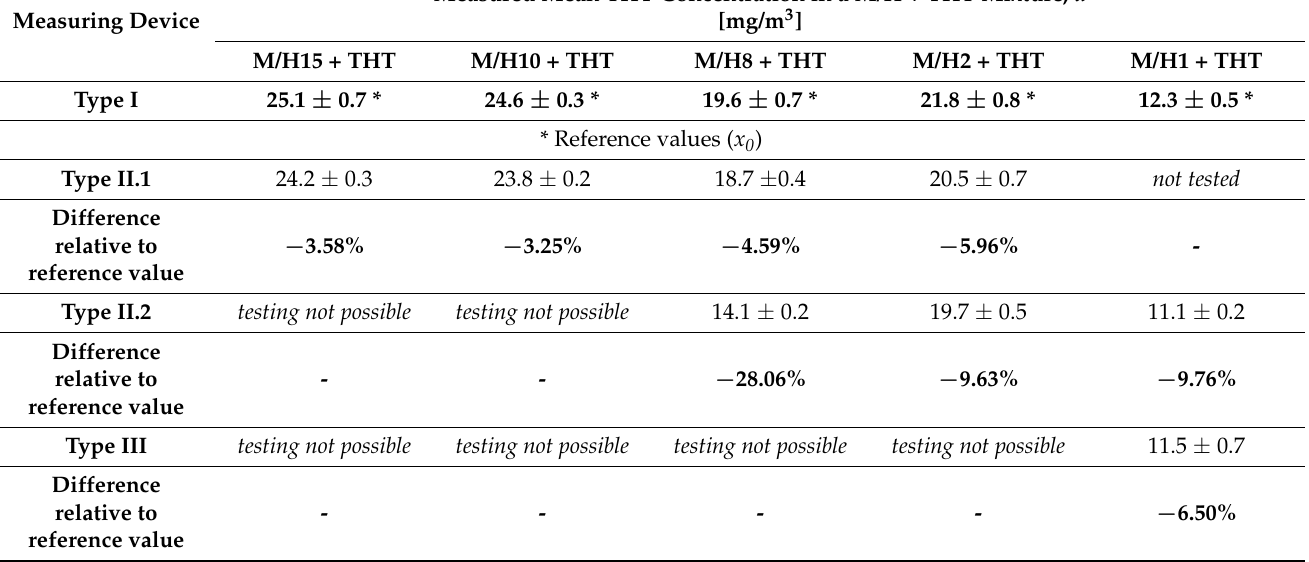
Table 7. List of comparative test results regarding the quality of THT concentration measurements in M/H + THT mixtures, for analyzers with an electrochemical